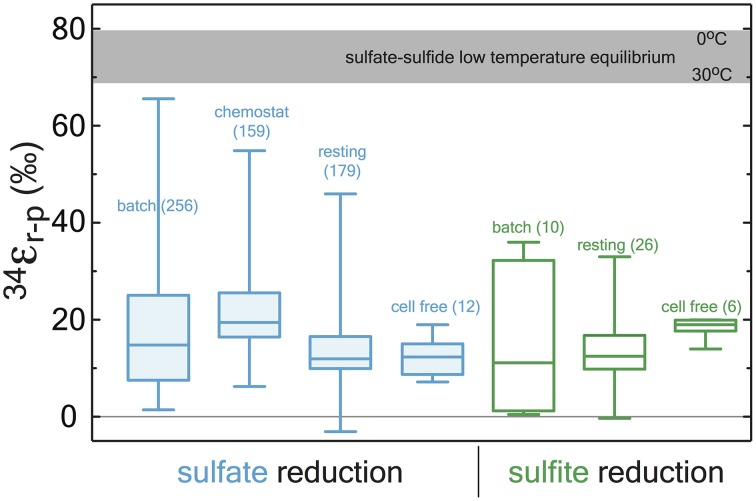
A box and whisker plot of previously published sulfate (blue) and sulfite (green) reduction experiments. All data is binned by experimental approach. The whiskers reflect the entire range of the data, with the boxes reflecting the middle 50% of the data. The median of the data is represented by the bar dividing the box. The bar running across the top is a temperature dependent prediction based on low temperature thermodynamic equilibrium (Farquhar et al., 2003). The statistical method and output are detailed in the Supplementary Material along with the compiled data (http://dx.doi.org/10.6084/m9.figshare.1436115), where all compiled values are from the following sources: (Thode et al., 1951; Ford, 1957; Harrison and Thode, 1957, 1958; Jones and Starkey, 1957; Kaplan and Rittenberg, 1964; Kemp and Thode, 1968; Krouse et al., 1968; Chambers et al., 1975; McCready, 1975; McCready et al., 1975; Smock et al., 1998; Bottcher et al., 1999; Bolliger et al., 2001; Detmers et al., 2001; Farquhar et al., 2003; Kleikemper et al., 2004; Habicht et al., 2005; Johnston, 2005; Canfield, 2006; Hoek et al., 2006; Knöller et al., 2006; Johnston et al., 2007; Mangalo et al., 2007, 2008; Pallud et al., 2007; Davidson et al., 2009; Sim et al., 2011a,b, 2012, 2013; Leavitt et al., 2013, 2014).